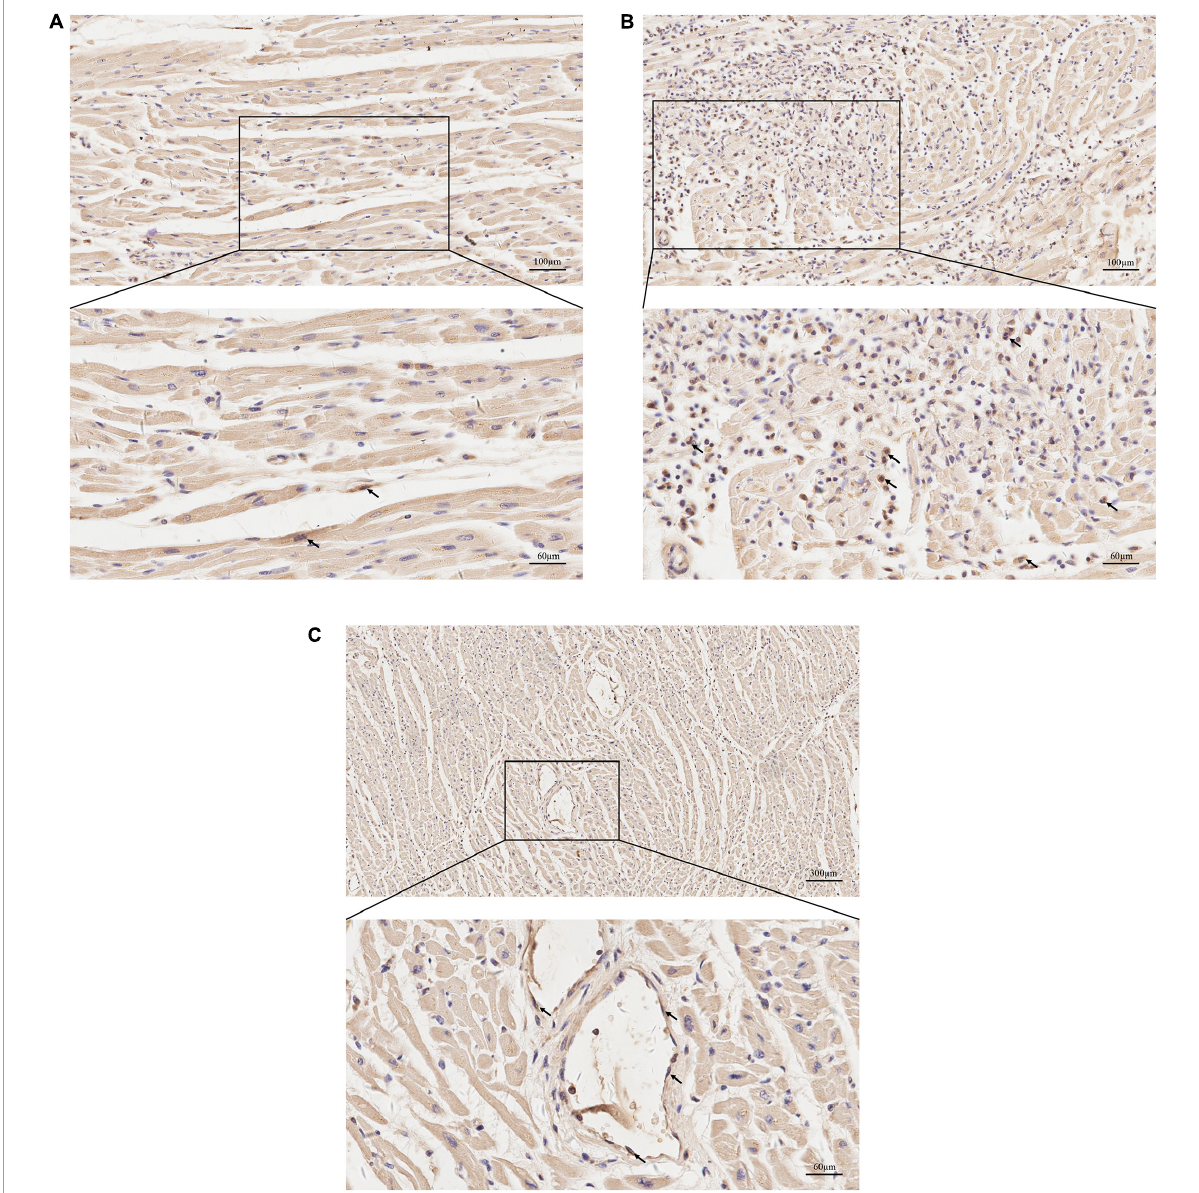
FIGURE2 Immunohistochemical staining for protein expression of spike receptor binding domain (RBD) in heart sections. (A) Representative images of immunohistochemical staining of heart section showed occasional spike RBD positive cardiomyocytes (arrows). (B) Representative images showing spike RBD expression in the infiltrating immune cells in myocardium (arrows). (C) Representative images showing spike RBD expression in the vascular endothelial cells in myocardium